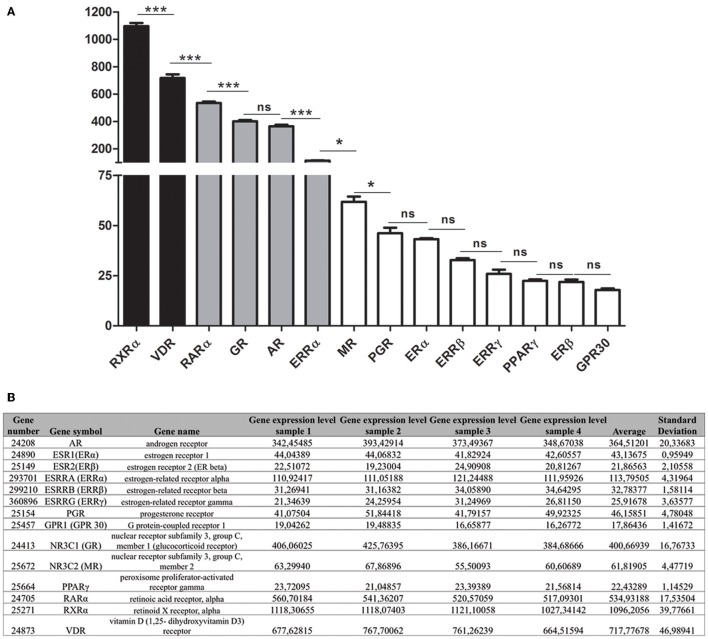
Relative level of expression of steroid hormone and vitamin receptors during the maturation stage. (A) The relative level of expression of each mRNA was determined by microarray analysis of RNAs extracted from maturation-stage enamel organ. Three main groups of receptors were distinguished: The RXRα and VDR were the most highly expressed (black bars); the GPR30, MR, PGR, ERα, ERRβ, and ERRγ weakly (white bars); and the RARα, GR, AR, and ERRα expression levels were intermediate (gray bars). PPARγ, GPR30 and ERβ were at the limit of the detection. Data resulted from microarray analyses of four RNA samples were presented as means ± SD and were compared using One way Analysis of Variance followed by Bonferroni's correction. The compared values were considered to be significantly different when *p <0.05, ***p <0.001. ns, non significant. (B) Raw microarray data and statistical analysis for the calculated mean levels of expression of the studied receptors.